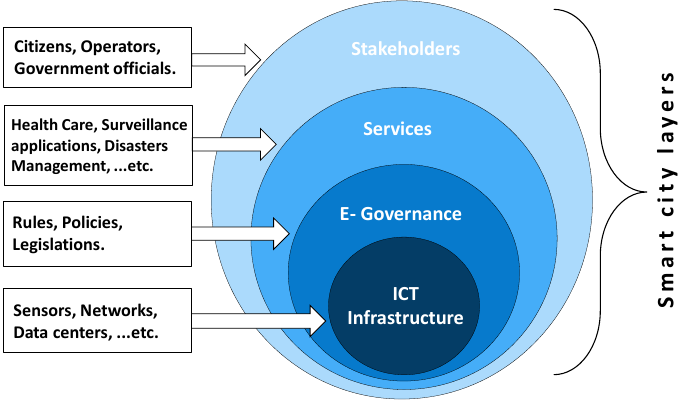
Figure 1. Smart city